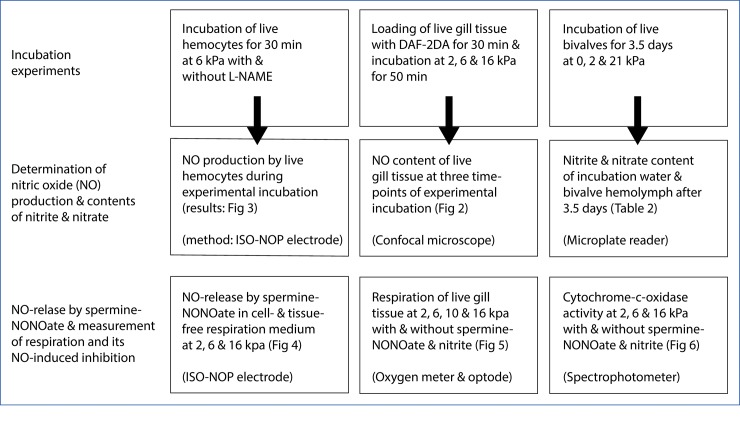
Overview of incubation experiments and laboratory analyses.